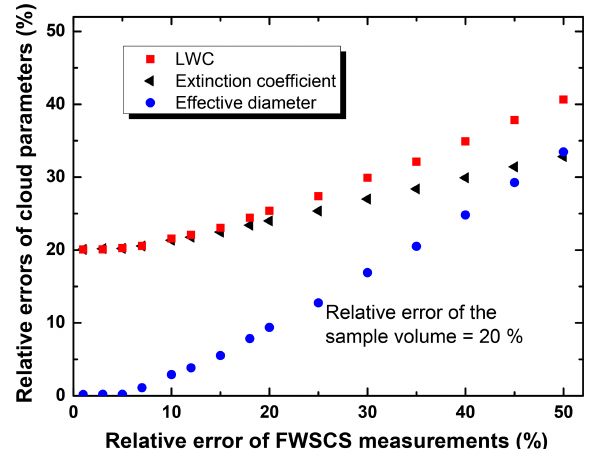
Figure 7. Relative errors of the LWC, the extinction coefficient and the effective diameter as functions of the relative error in measuring the FWSCS. Different scales have been used on the axes in order to reach a convenient aspect ratio of the